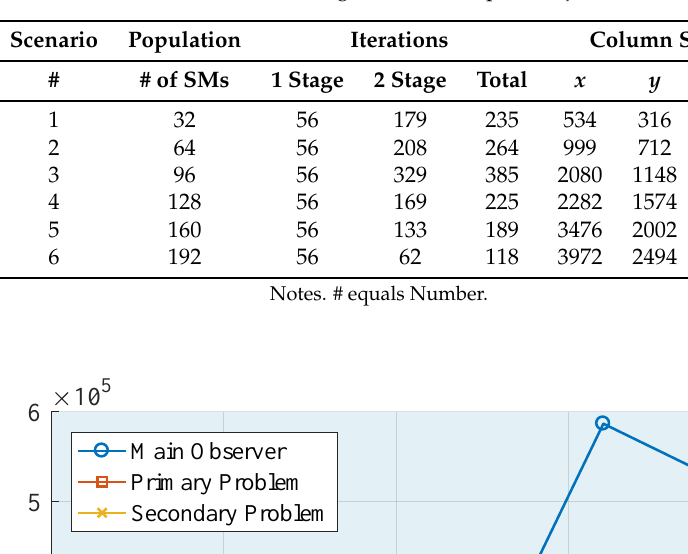
Table 7. Iterations for each stage: revised simplex/objective function.